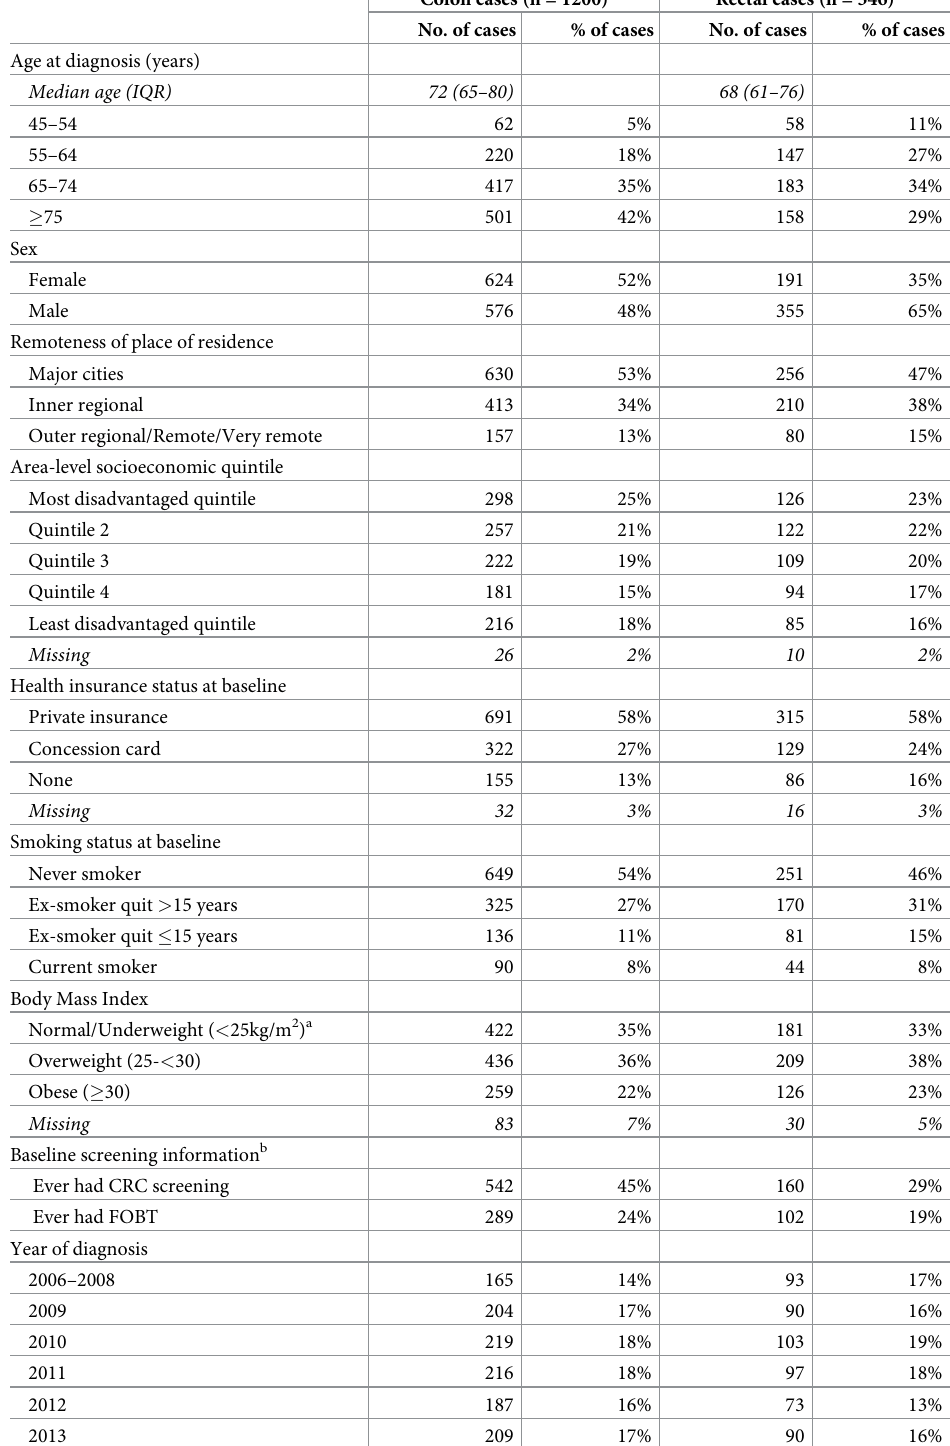
Table 1. Sociodemographic, diagnosis and treatment characteristics of colon and rectal cancer cases diagnosed 2006–2013 in the 45 and Up